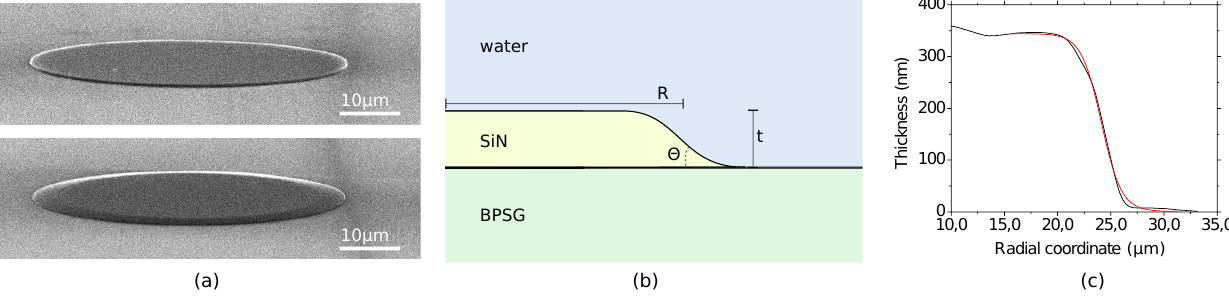
Figure 1. ( a ) SEM micrographs of vertically-coupled monolithically-integrated disk and wedge microresonators. The buried waveguide can be barely seen below the surface. Note the difference in sidewall angle; ( b ) Model of the cross-section profile of the wedge WGM resonator. R , t and θ are, respectively, the radius, thickness and inclination angle; ( c ) AFM profile of the sidewall of a wedge resonator. The red line is the fitted logistic function (1). Note that the axes’ scales have been modified to properly show the small aspect-ratio of the